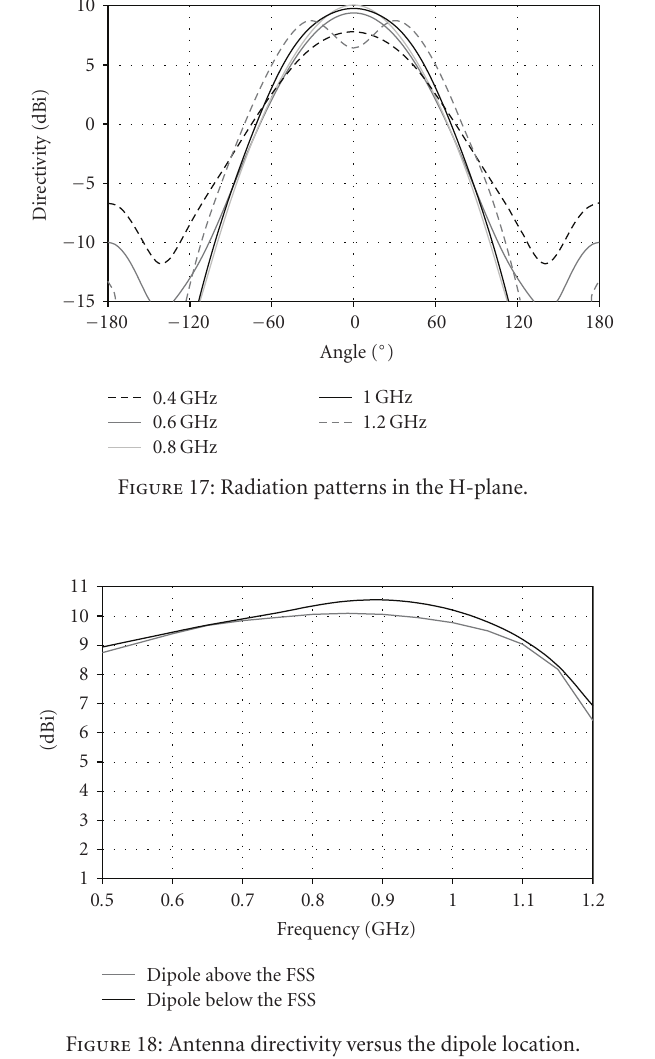
Figure 18: Antenna directivity versus the dipole location.